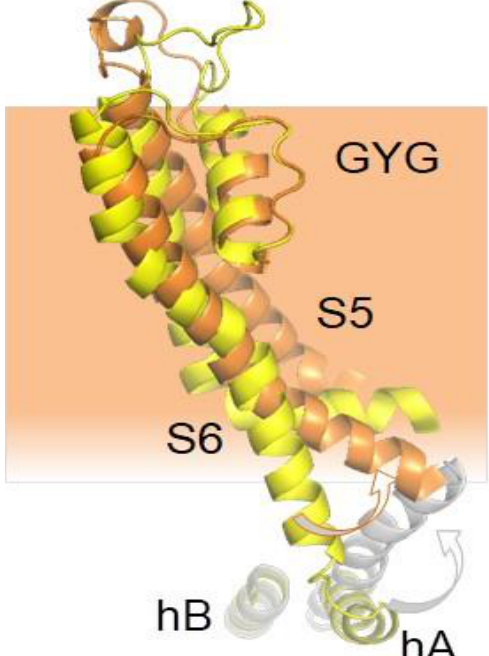
Figure 14. Possible direct gating transmitted from helix A to S6 in KCNQ2 channels. Comparison of the movement of S6 from a model (orange [122]) of KCNQ2 opening with the position of helix A upon C-lobe Ca 2+ loading (grey, PDB 6FEH).